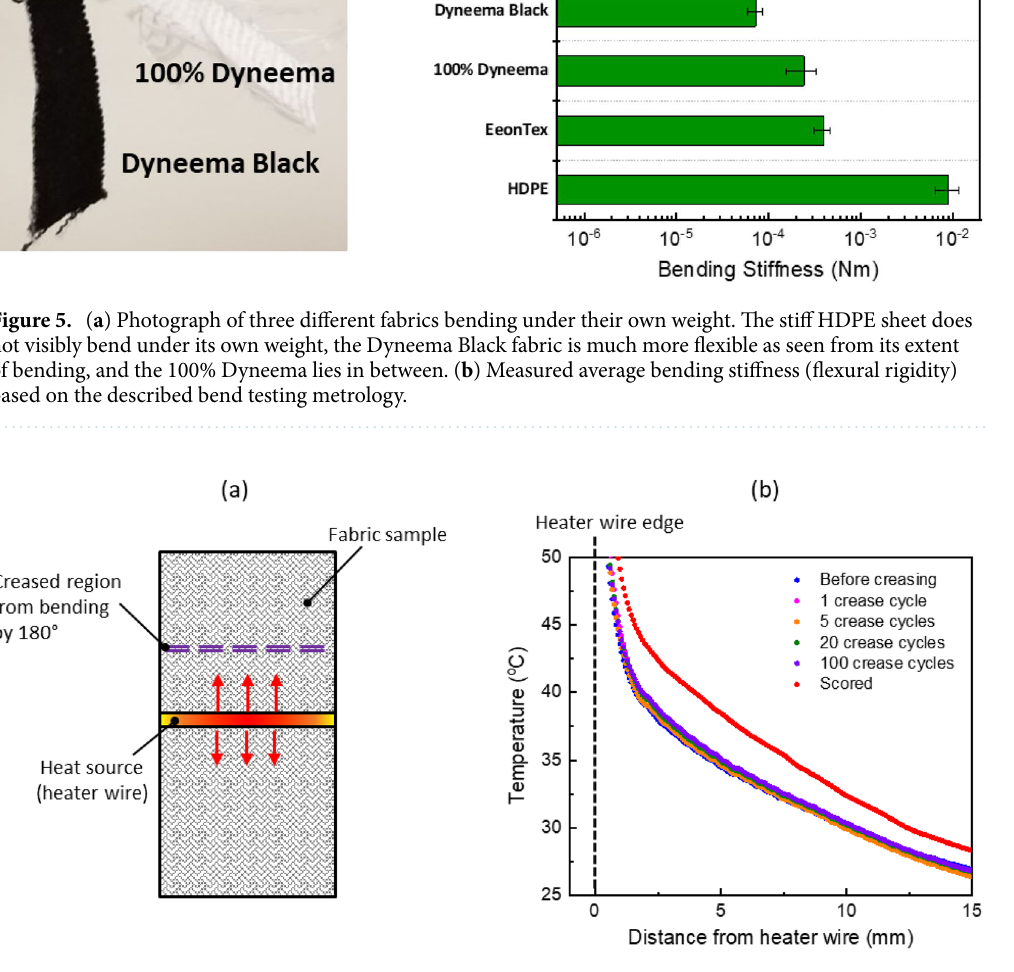
Figure 6. ( a ) Schematic diagram showing the top-view of the testing configuration to assess impact of creasing on thermal performance. The fabric sample is creased by bending by 180° at a specific location as indicated, and infrared temperature maps are captured before and after creasing. ( b ) Steady state temperature profile as a function of distance from the heater wire on the creased side of the fabric swatch, shown for increasing number of crease cycles and after scoring. The temperature profiles indicate no significant change in heat spreading properties except for the extreme scenario of scoring to purposely damage the individual